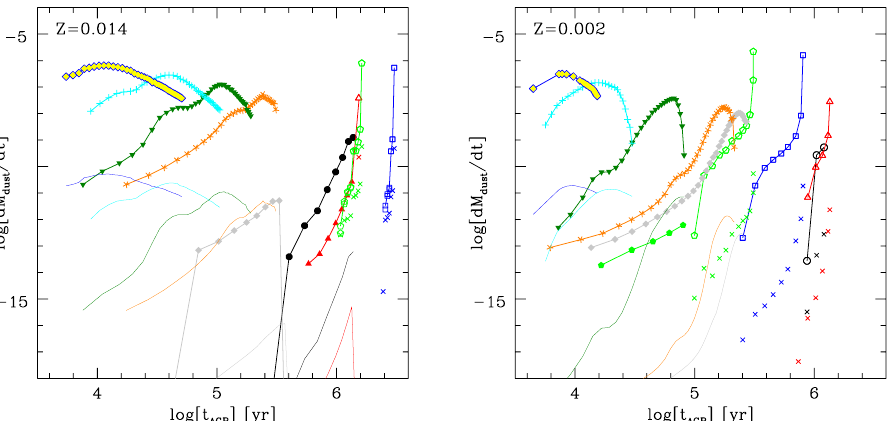
Figure 5. ( Left ) Time variation of the dust production rate of model stars of different initial mass and solar metallicity. The same symbols as in Figures 3 and 4 were adopted to indicate the stars of different initial mass. Full points refer to dust composed by silicates and alunina dust, while open points indicate carbonaceous dust. Thin solid lines and crosses indicate the contribution from alumina dust and SiC dust, respectively. ( Right ) Same at the left panel, for the Z = 2 × 10 − 3